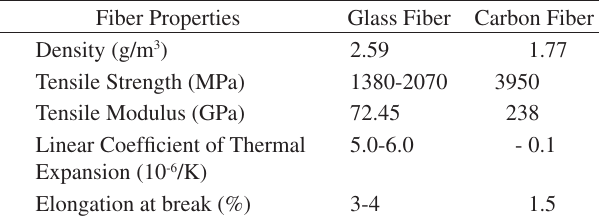
Table 2. Thermal and mechanical properties of Glass and Carbon fibers.